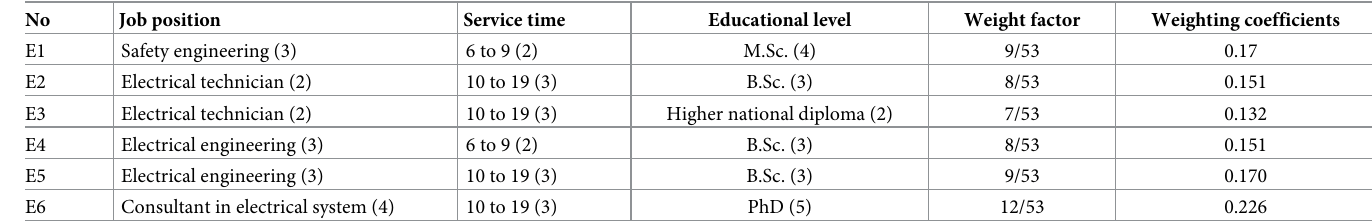
Table 7. Expert weighting